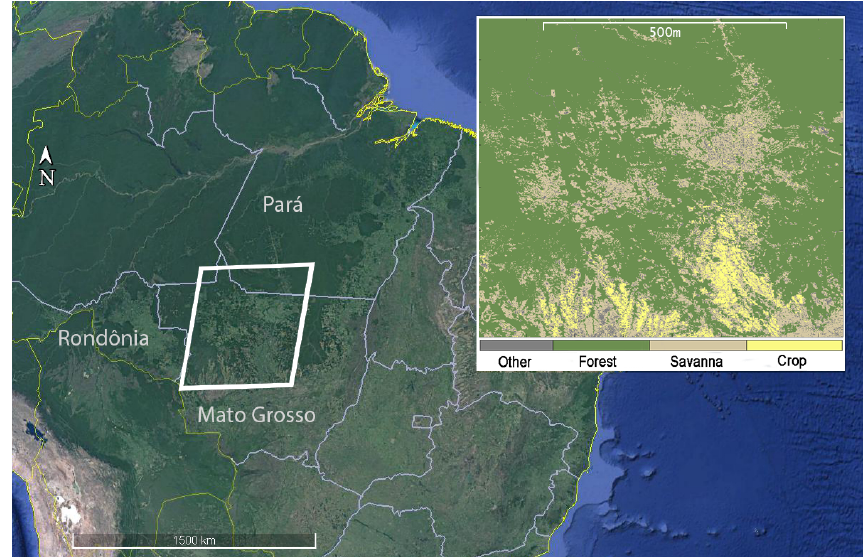
Figure 1. Study area of the arc of deforestation of the Amazon, in northern Mato Grosso. The inlaid image shows the MODIS land cover classification map (2001) for the three land cover classes analysed. Forest – green, Savanna – beige, Crop – yellow, and Other – grey. Due to the sinusoidal projection of MODIS satellite data, the study area looks distorted. Satellite image data: © Google Earth, Landsat/Copernicus.